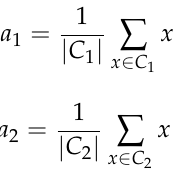
Figure 3. Process of the candidate important areas generation. Four traditional image-processing methods are employed, i.e., K-means++, dilation algorithm, median filtering, and the RLSA